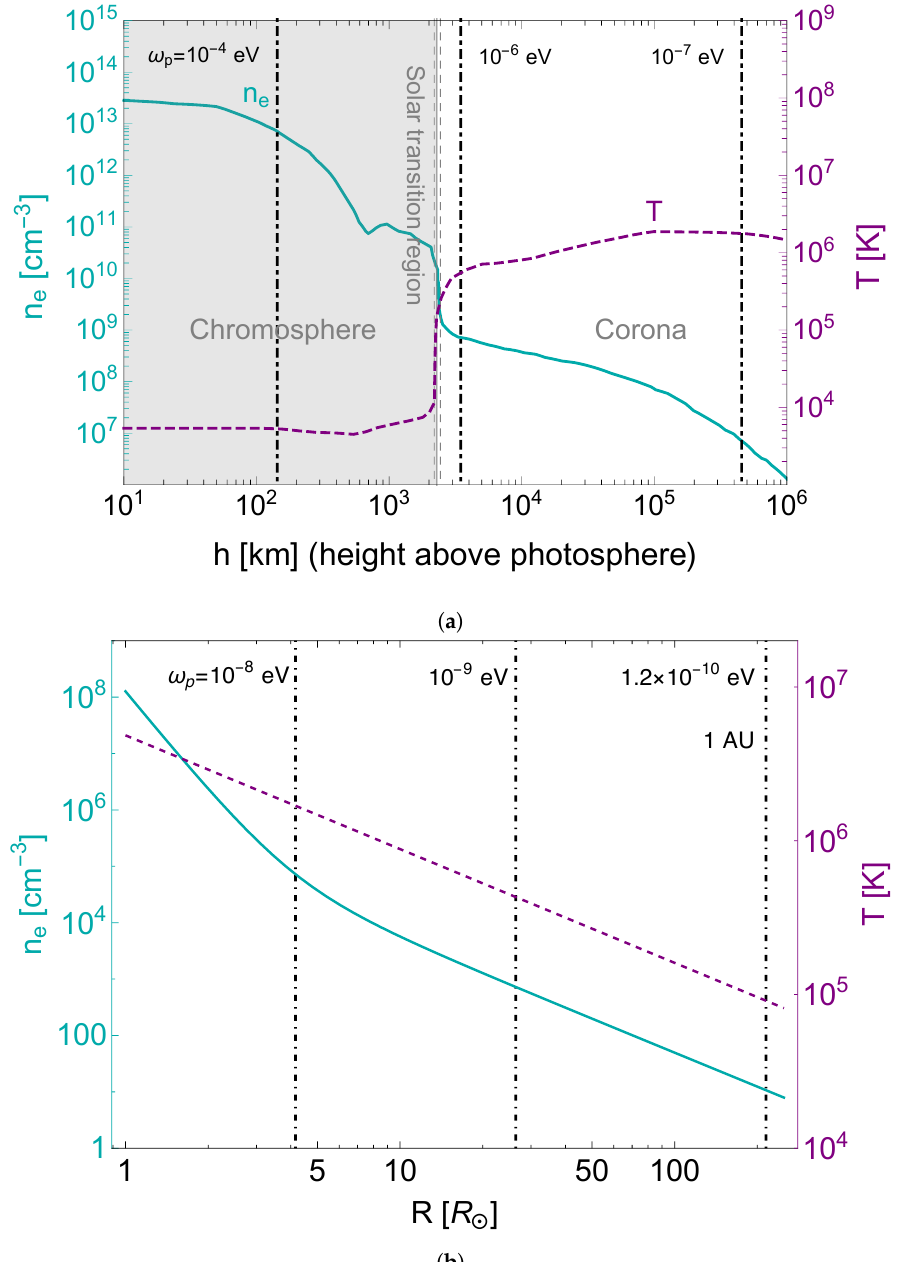
Figure 1. ( a ) Quiet-Sun electron density n e and temperature T profiles in the solar atmosphere above the photosphere. Figure adapted from [67] based on the result of [68]. ( b ) n e and T (thermal tem- perature of electrons) profiles in the solar-wind plasma with the distance extending up to about 1 AU. The n e profile is based on the in situ measurements of the Parker solar probe [69] and then (cid:2) fitted by the relation n e ( r ) ∼ 3.3 × 10 5 ( r / R (cid:12) ) − 2 + 4.1 × 10 6 ( r / R (cid:12) ) − 4 + 8.0 × 10 7 ( r / R (cid:12) ) − 6 given in [70]. The T profile is the relation T ( r ) ∼ 418 eV × ( r / R (cid:12) ) − 0.74 [69] based on the in situ